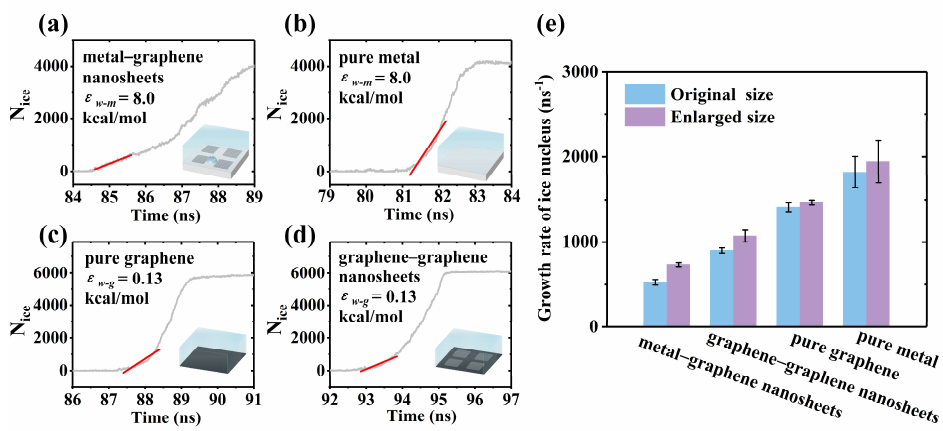
Figure 5. Growth rate of an ice nucleus on different surface configurations. ( a ) Number of water molecules in the ice nucleus, N ice , changed with simulation time on the metal–graphene nanosheet surface. ( b – d ) N ice on a pure metal, pure graphene and graphene–graphene nanosheet surface, respectively. The data refer to ε w-m = 8.0 kcal/mol both in ( a , b ). The red line in each figure is the linear fitting of N ice within the first 1 ns after the initiation of icing. ( e ) Comparison of the ice growth rate on different surface configurations. Blue and purple bars represent the original and enlarged size of the simulation box.